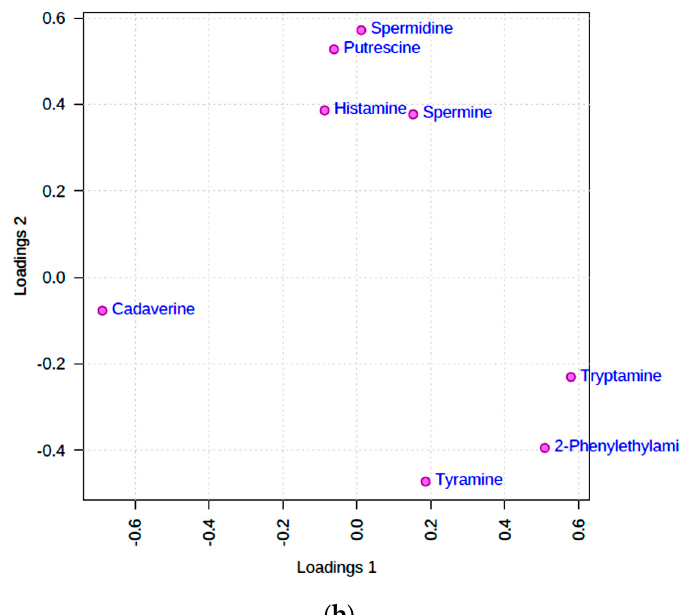
Figure 6. PLS-DA evaluation of revised dataset with combined fish, fish sauce/paste, and vegetable sauce classifications (abbreviated COMBO); CS-normalization was applied to the dataset prior to analysis. ( a ) 3D PLS-DA component 3 vs. component 2 vs. component 1 scores plot revealing some clustering of the fermented food classifications (i.e., cheese, wine/vinegar, FCLO, and COMBO). ( b ) Corresponding component 2 vs. component 1 loadings plot for this PLS-DA analysis.